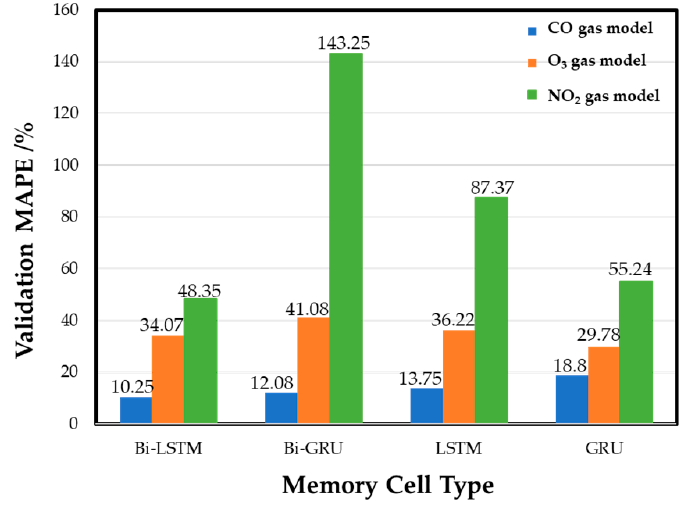
Figure 12. Effects of different memory cells on gas